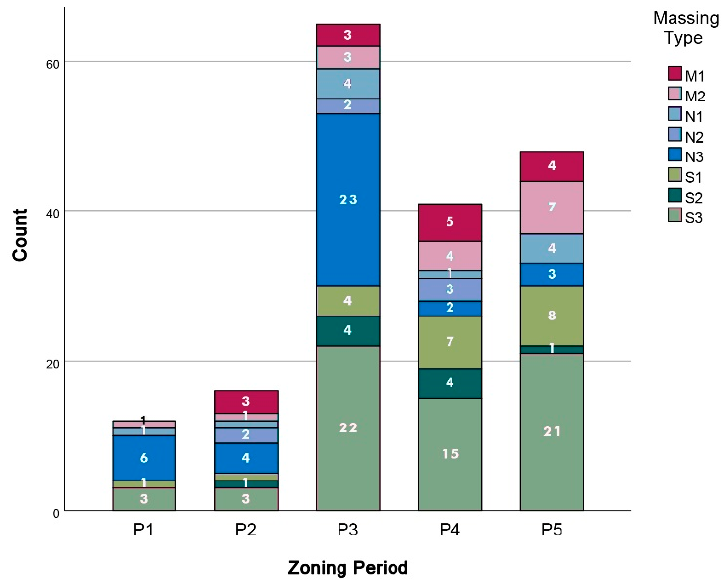
Figure 14. Number of properties per zoning period.